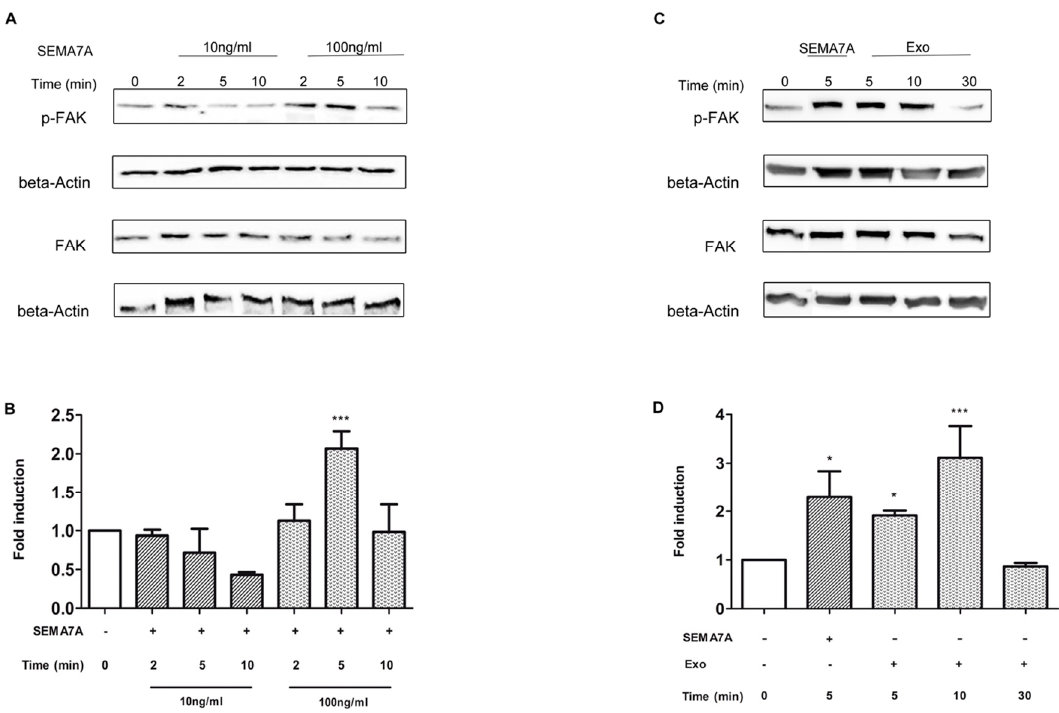
Figure 4. SEMA7A (Semaphorin7A) and Glioma Associated Stem Cells (GASC)-derived exosomes activate FAK signalling on glioma stem cells. ( A , B ) Glioma Stem Cells (GSC) were treated with either recombinant SEMA7A-Fc for 2, 5 and 10 min at 10 ng / mL or 100 ng / mL and paired GASC-derived exosomes (10 µ g / mL) for 5, 10 and 30 min ( C , D ). Total cells lysates were resolved on 10% Sodium Dodecyl Sulphate PolyAcrylamide Gel Electrophoresis (SDS-PAGE) and blotted to identify the phosphorylated and non-phosphorylated form of focal adhesion kinase protein (FAK) ( A , C ). ( B , D ) Densitometric analysis was performed using the software available in the Gel-doc instrument (Alliance Uvitec, Ltd. Cambridge, UK) to quantify the level of FAK (Focal Adhesion Kinase) phosphorylation. Histograms represent results reported as fold change of p-FAK of treated vs. untreated cells (Ctrl). Values were calculated as the ratio of IOD (Integrated Optical Density) pFAK / FAK after normalisation on beta actin level. Data are presented as mean ± standard deviation ( n = 4). *** p < 0.001 vs. Ctrl; * p < 0.05 vs. Ctrl. Statistical analysis was performed by repeated measurements one-way Anova followed by